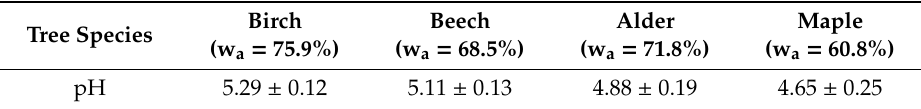
Table 3. Average values of the pH of green wood.